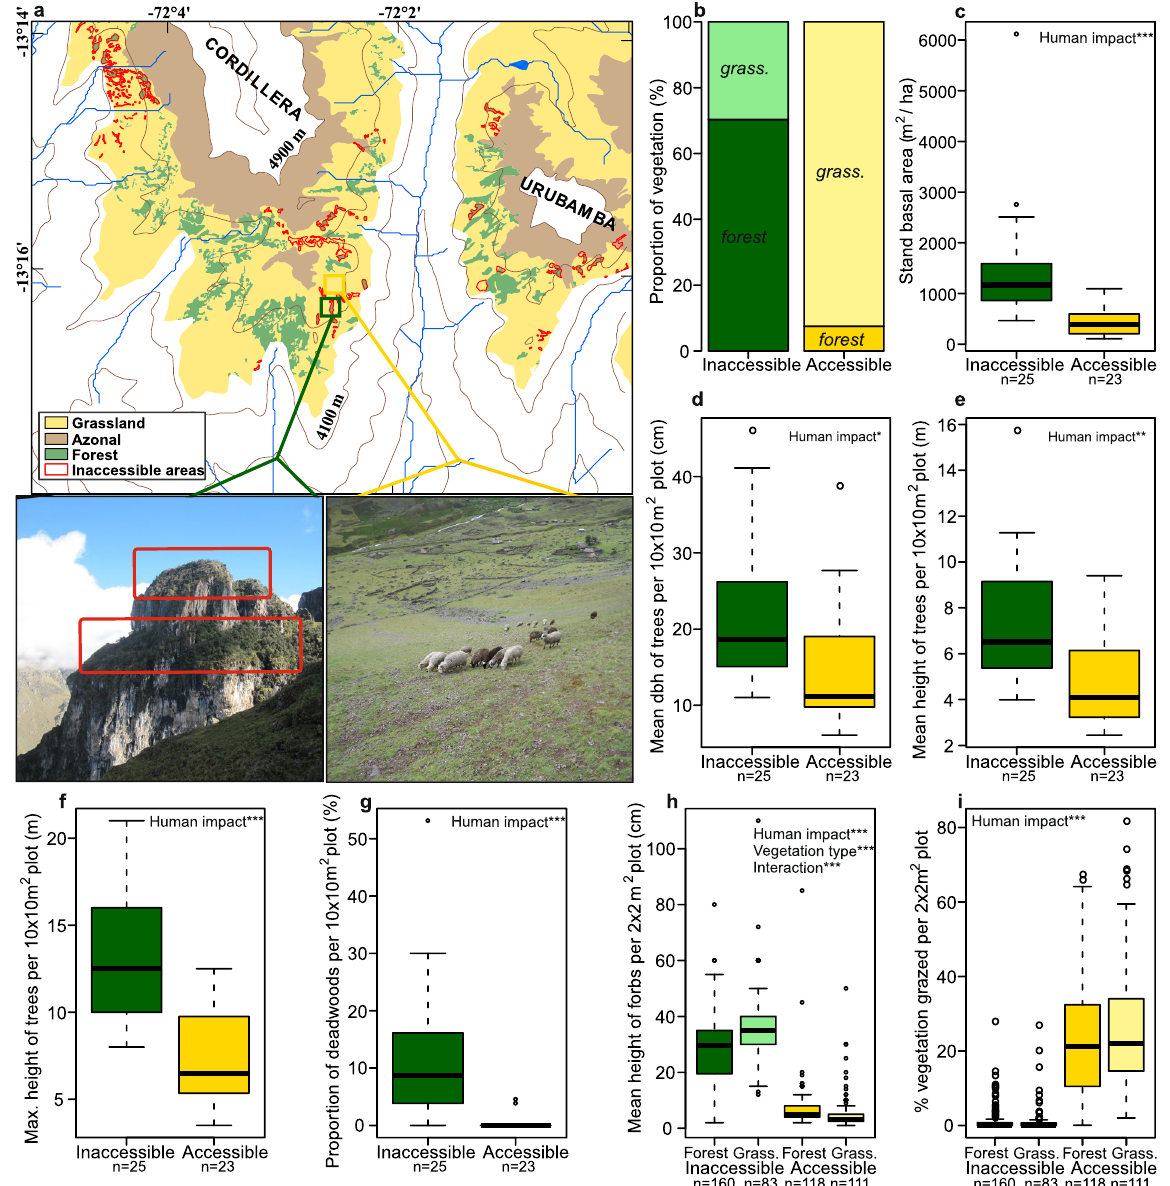
Figure 2. Comparisons of inaccessible and accessible vegetation structure. ( a , b ) Example of the landscape mapping approach showing an inaccessible and nearby accessible site ( a ) and the total proportion of forest and grassland of zonal vegetation in the Cordillera Urubamba between 4200 m and 4900 m calculated from this ( b ). ( c – g ) Comparisons of forest structure i.e. stand basal area ( c ), mean dbh ( d ), and mean ( e ) and maximum height ( f ) of trees, and proportion of deadwoods ( g ), per 10 × 10 m 2 forest plot in accessible and inaccessible Polylepis forests. ( h , i) Comparison of mean height of herbaceous vegetation ( e ) and vegetation cover grazed ( i ) per 2 × 2 m 2 plot in inaccessible and accessible forest and grassland. Significant relationships between the structural properties and fixed effects (human impact; vegetation type) found upon analysis using generalized linear mixed models (GLMM’s) are noted within the figures ( *** p < 0.001, ** p < 0.01, * p < 0.05; Tables S13 and S14). Photographs by S.P. Sylvester. Map generated using ArcGIS v.10.1